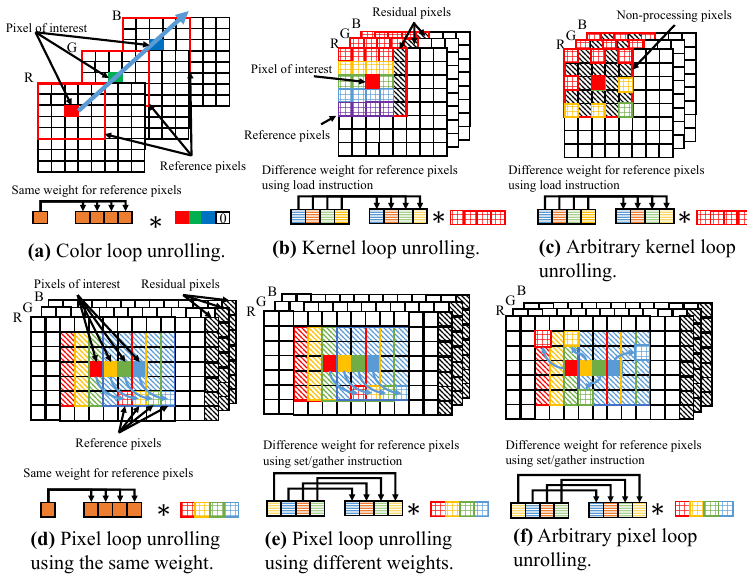
Figure 5. Vectorization pattern of vectorized programming: ( a ) indicates color loop unrolling. ( b ) indicates kernel loop unrolling. ( c ) indicates arbitrary kernel loop unrolling. ( d ) indicates pixel loop unrolling using the same weight for the reference pixels. ( e ) pixel loop unrolling using different weights for the reference pixels is shown. ( f ) indicates arbitrary pixel loop